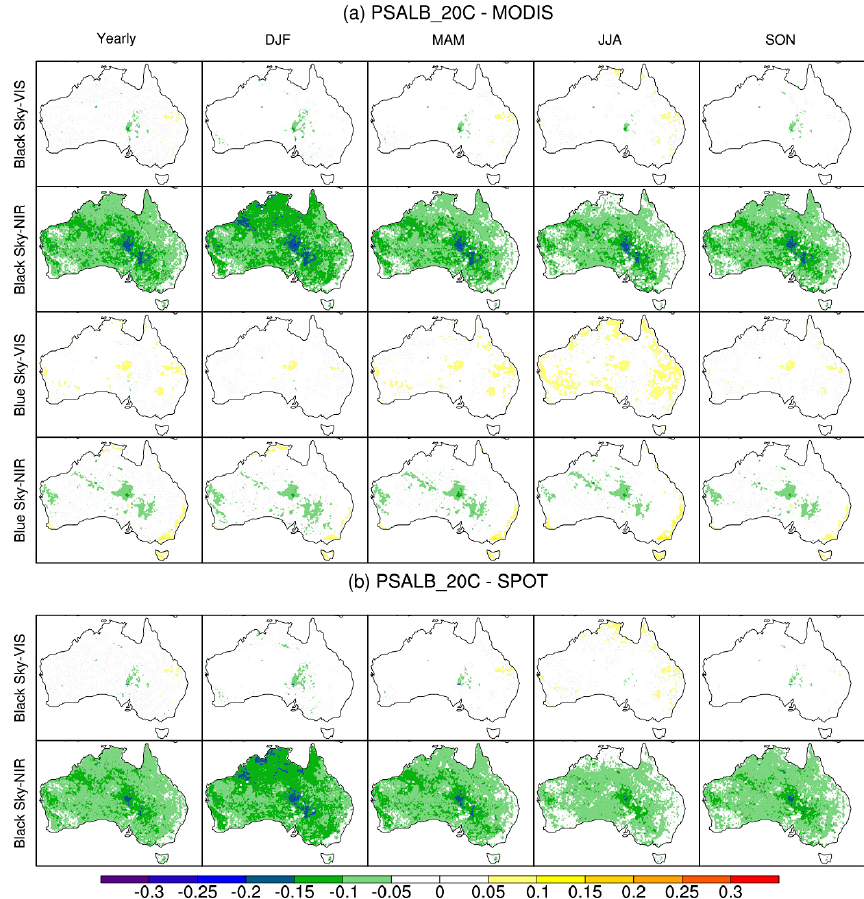
Figure 14. Same as in Fig. 12 but for the PSALB_20C